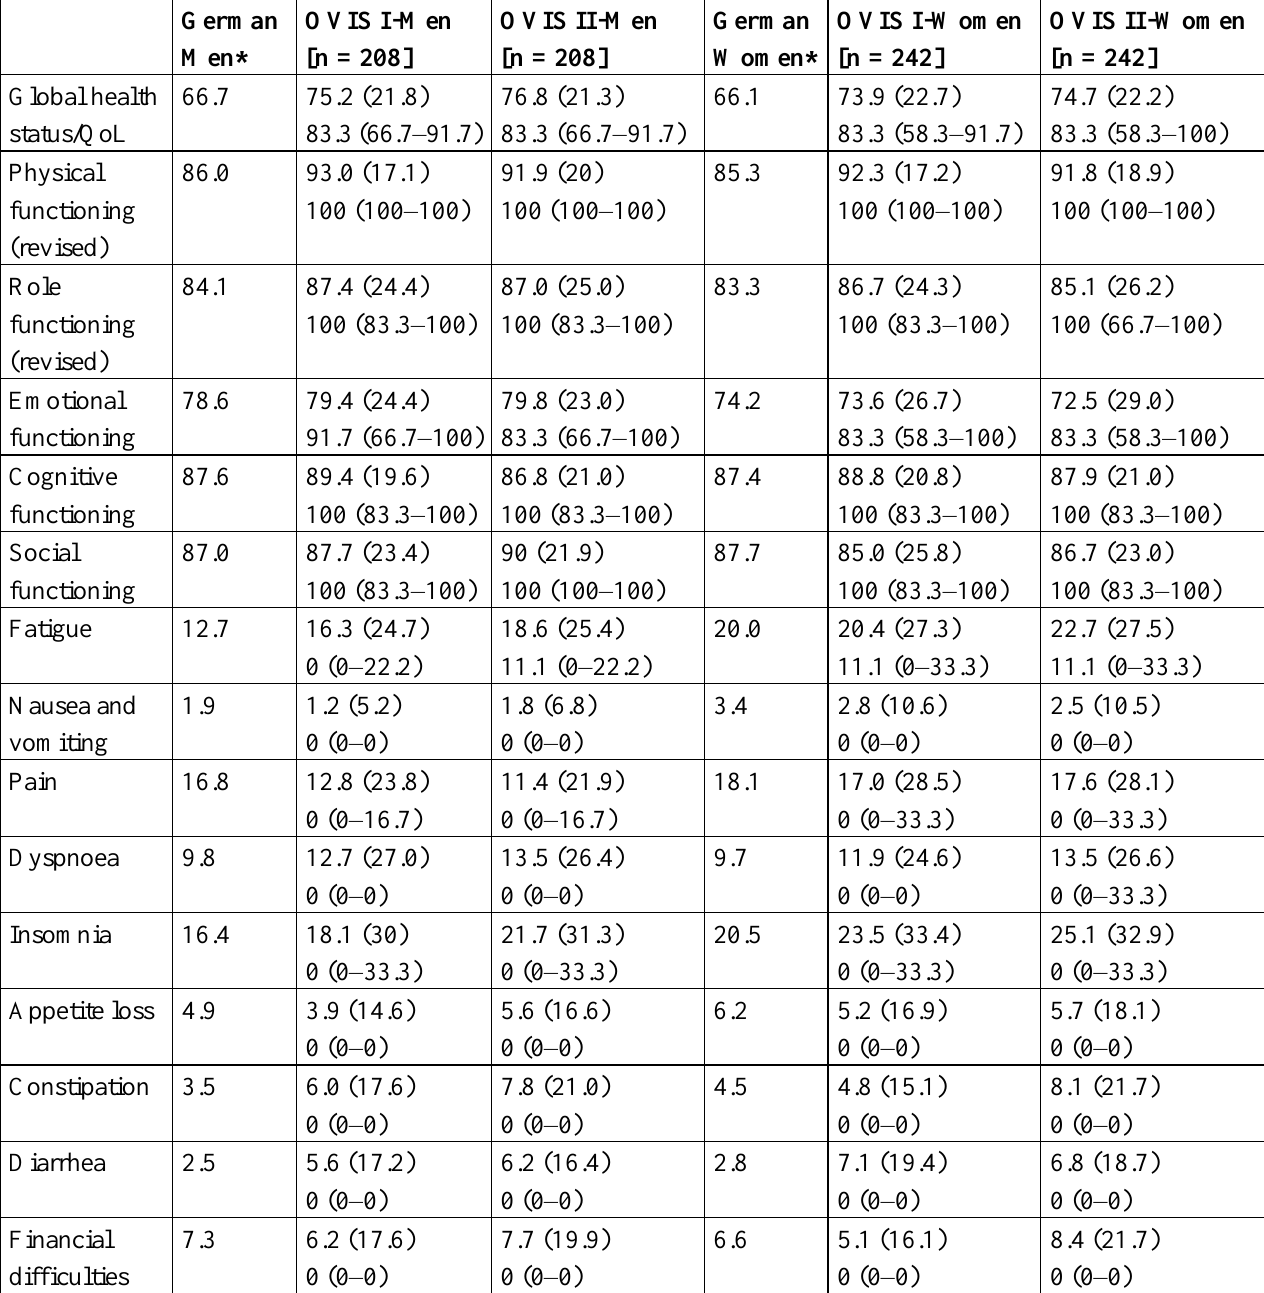
Table 3. Mean (SD) and median (25th–75th percentiles) EORTC QLQ-C30 scores of German melanoma patients at baseline (Q1; OVIS I) and follow-up (Q2; OVIS II) and the German reference